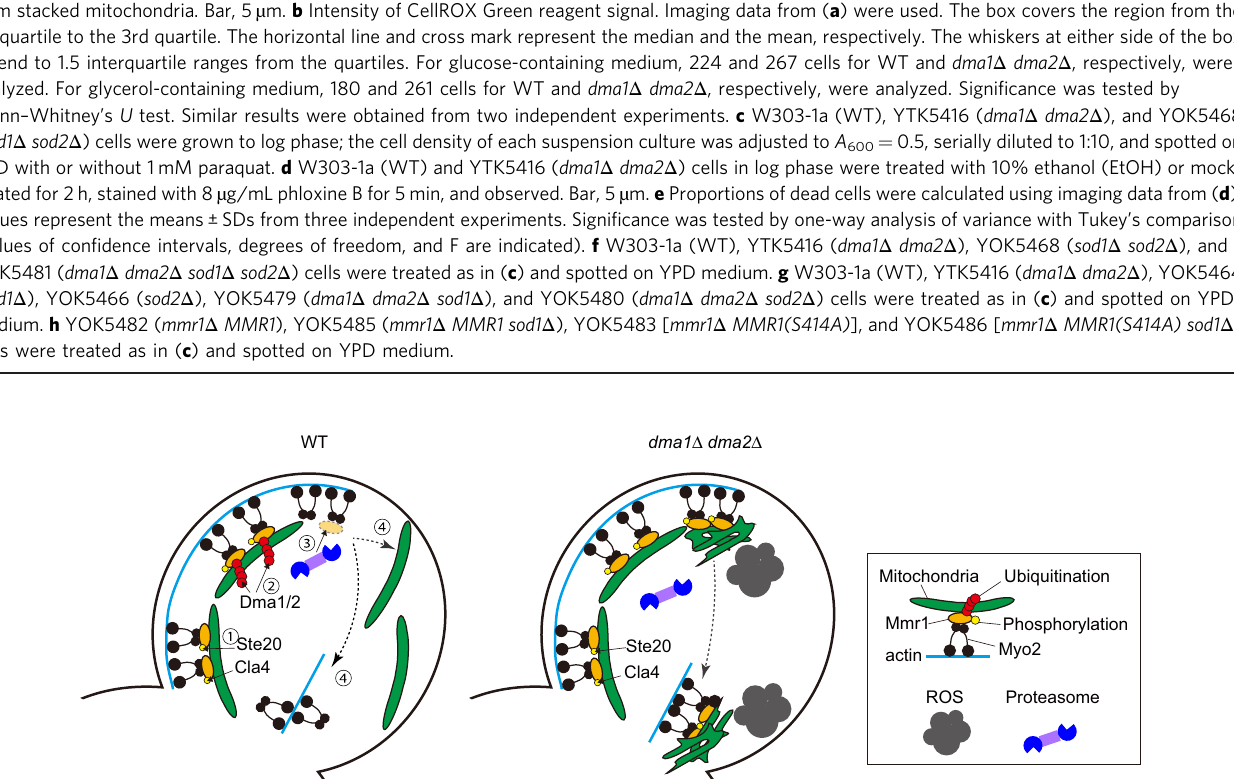
Fig. 9 Model for release of mitochondria from myosin in the bud. In WT cells, mitochondria are transported to the growing bud by Myo2 on the actin cable. After mitochondria entered the growing bud, bud-localized kinases, Ste20 and Cla4, phosphorylate the adaptor protein Mmr1, most likely at S414 residue (step 1). Redundant E3 ligases, Dma1 and Dma2, recognize and poly-ubiquitinate the phosphorylated Mmr1 (step 2). Poly-ubiquitinated Mmr1 is degraded by the proteasome (step 3). Liberated mitochondria are widely distributed in the bud, while Myo2 moves to the bud neck (step 4). In dma1 Δ dma2 Δ cells, transported mitochondria are not released from Myo2, get stacked at the bud tip, and are deformed. Owing to the translocation of Myo2 to the bud neck, the mitochondria are transported to the bud neck and again get stacked there. Stacked and deformed mitochondria generate a higher level of ROS compared to normal mitochondria in WT